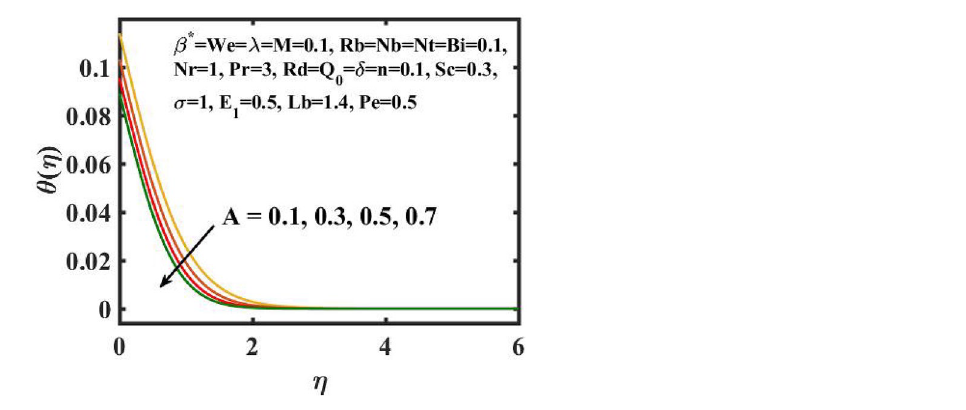
Figure 6. Encouragement of A on θ(η) .